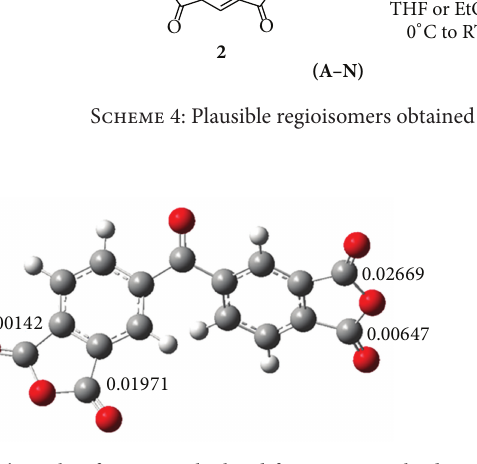
Figure 4: The Fukui function calculated for atoms involved in the ring-opening of dianhydride 1 .